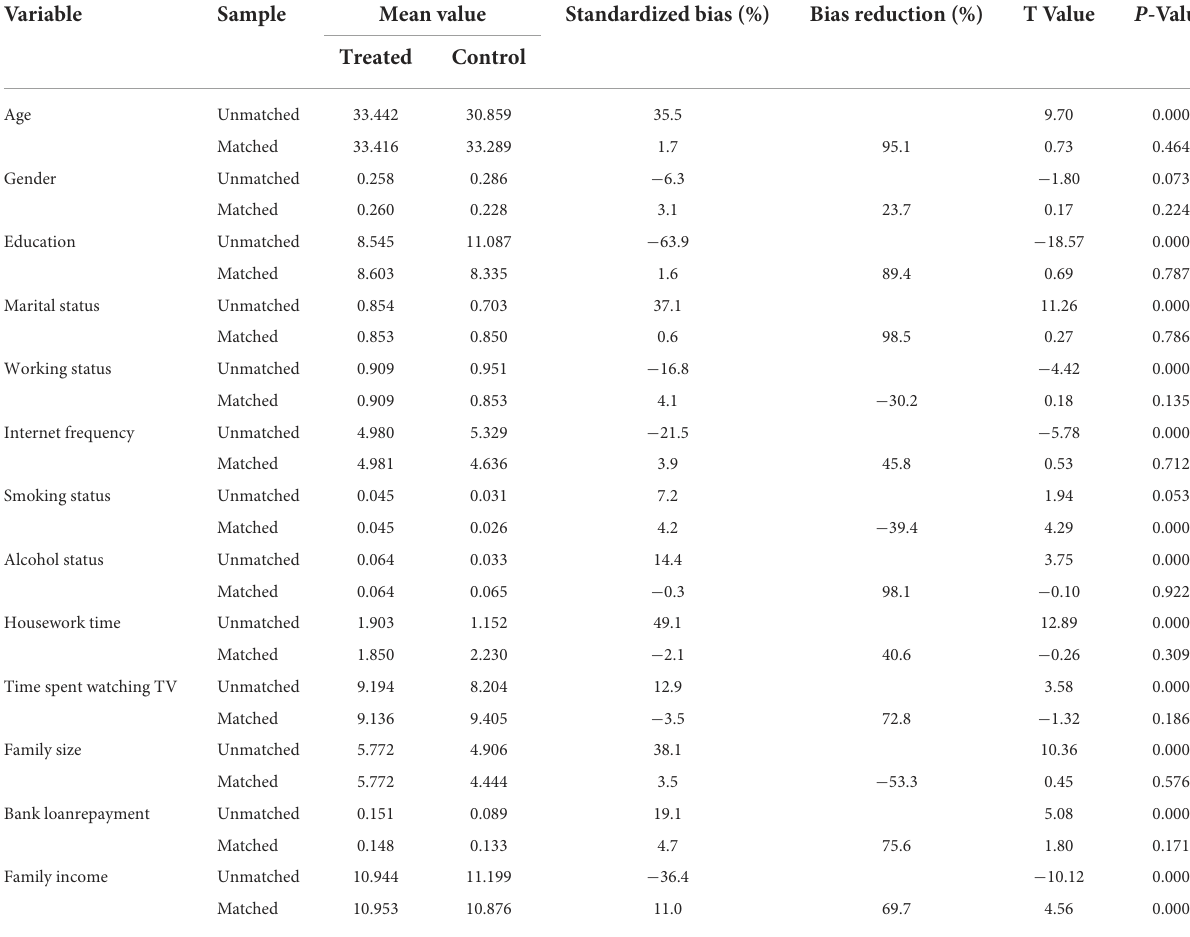
TABLE 6 Comparison of sample characteristics before and after matching.